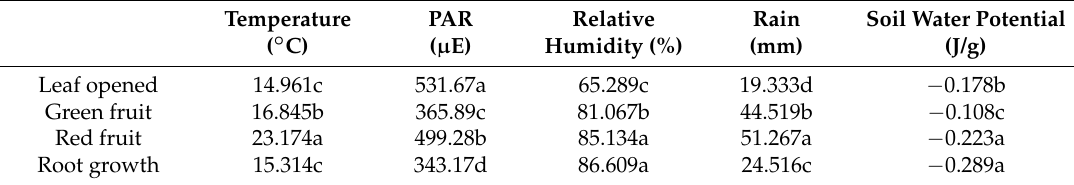
Table 2. Ecological factor data in different growth times.